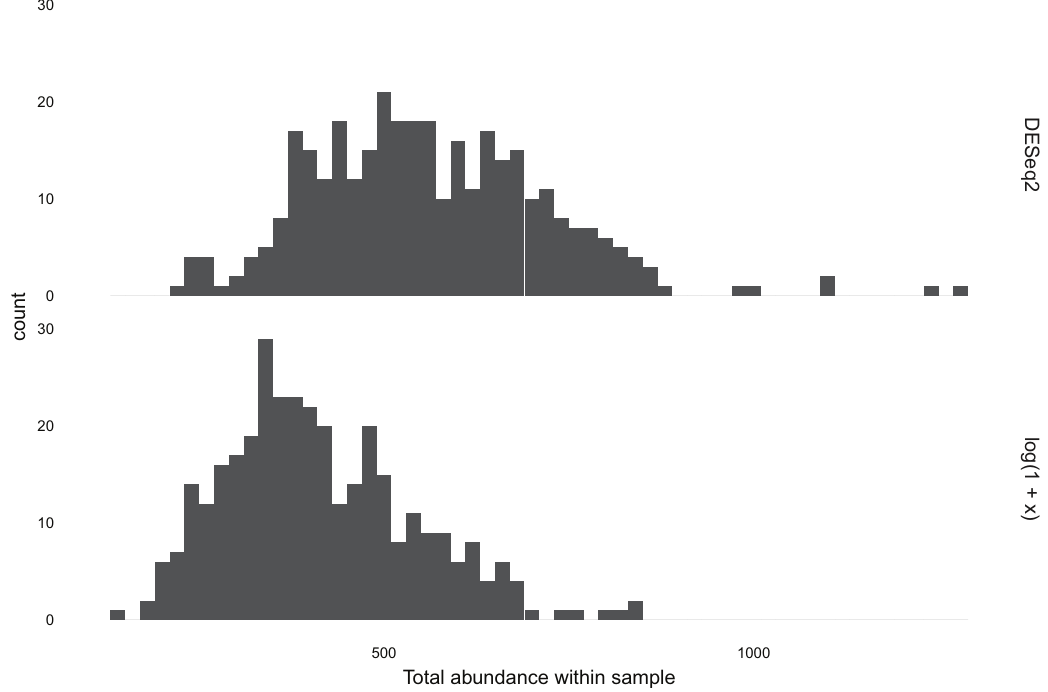
Figure 27. The histogram on the top gives the total DESeq2 transformed abundance within each sample. The bottom histogram is the same as that in Figure 7, and is included to facilitate comparison.